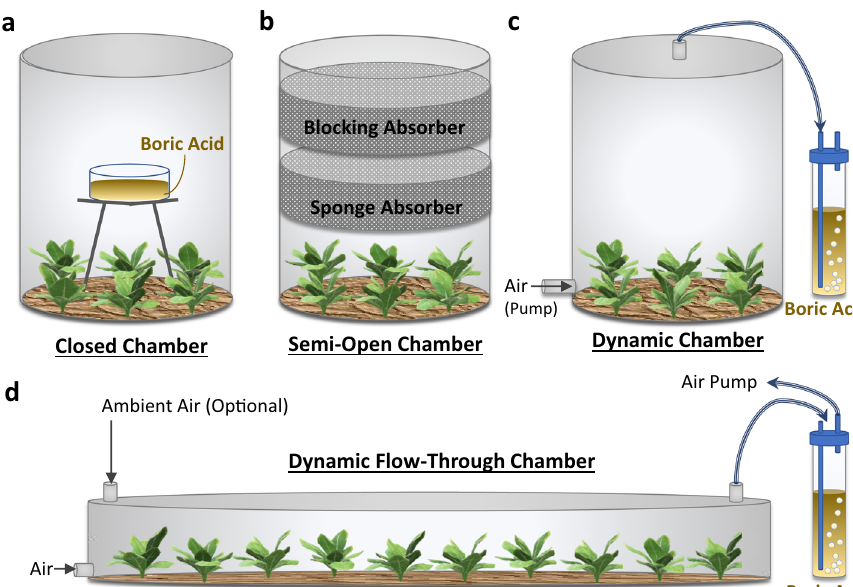
Fig. 2 Several examples of chambers for sampling and measuring NH 3 volatilization. a Closed static chamber; b semi-open chamber; c dynamic chamber-capture system; d dynamic fl ow-through